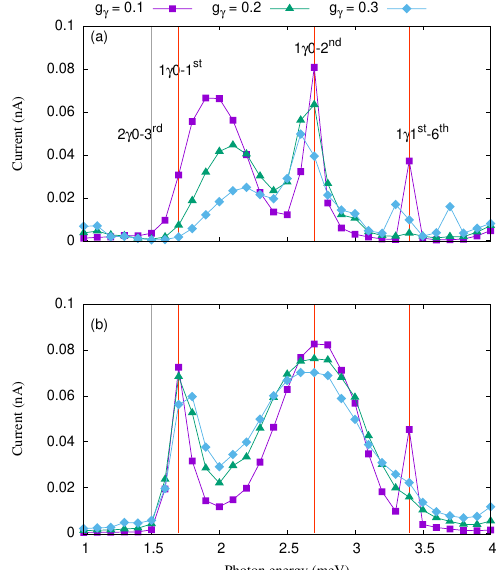
Figure 7. Current versus the photon energy for g γ = 0.1 (purple squares), 0.2 (green triangles), and 0.3 meV (blue diamonds) in the case of x - ( a ) and y -polarized ( b ) photon field. The cavity–reservoir coupling is κ = 10 − 5 , and n R = 1. The vertical red lines indicates the positions of the main resonance states. The chemical potential of the left leads are µ L = 1.65 meV and µ R = 1.55 meV. The magnetic field is B = 0.1 T, eV g = 0.651 meV, T L,R = 0.5 K, and ¯ h Ω 0 = 2.0